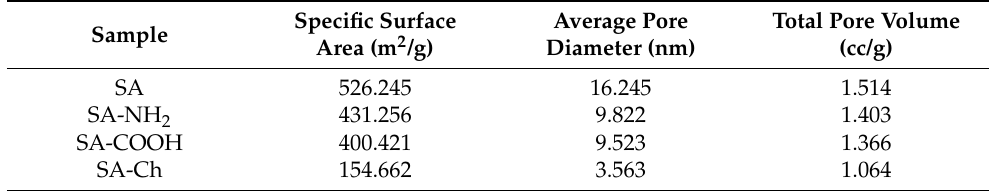
Figure 6. Adsorption–desorption isotherm curves ( a ) and pore-size distribution ( b ) of the original SA and modified SAs. Table 2. Textural parameter summary of SA, SA-NH 2 , SA-COOH, and SA-Ch.